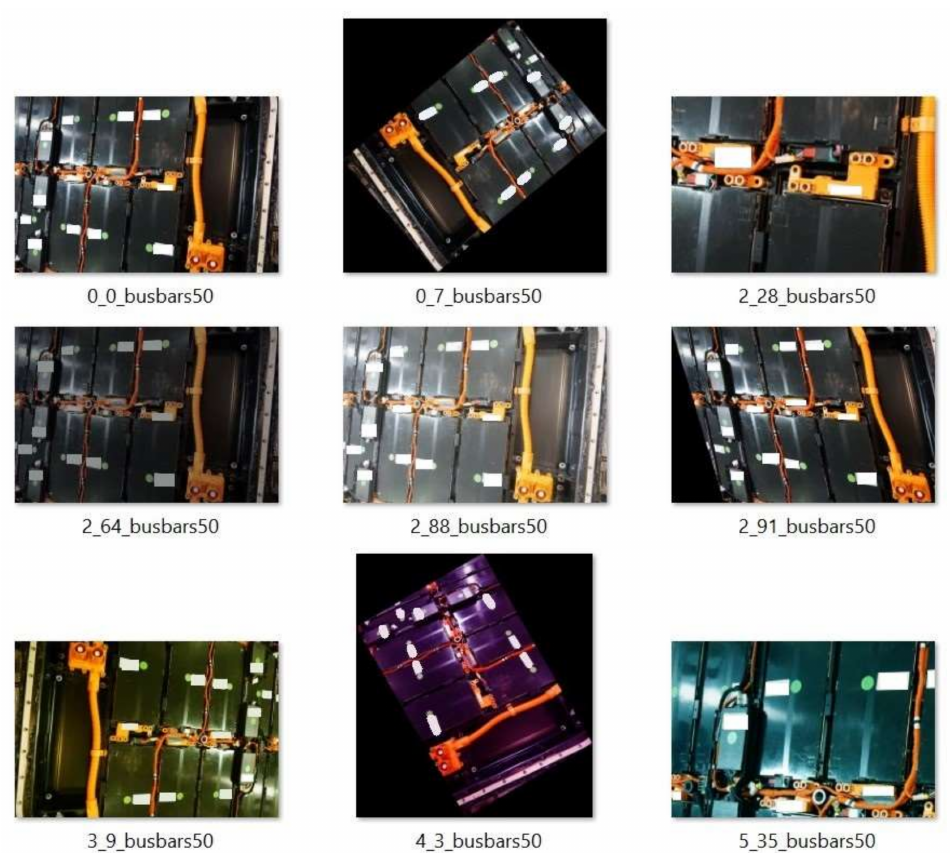
Figure 10. Examples of images that were derived by data augmentation from the original image ( top left